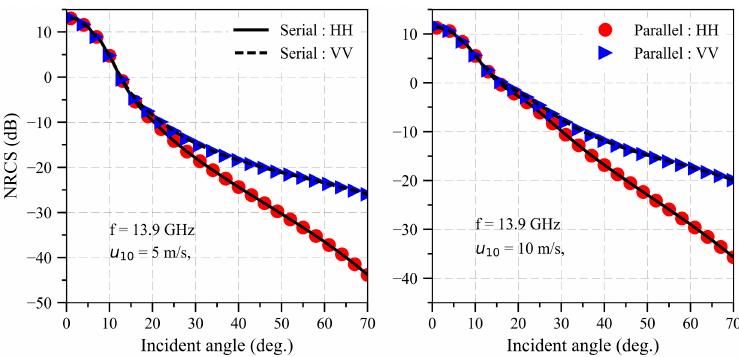
Figure 15. NRCS results of parallel program compared with that of serial program.